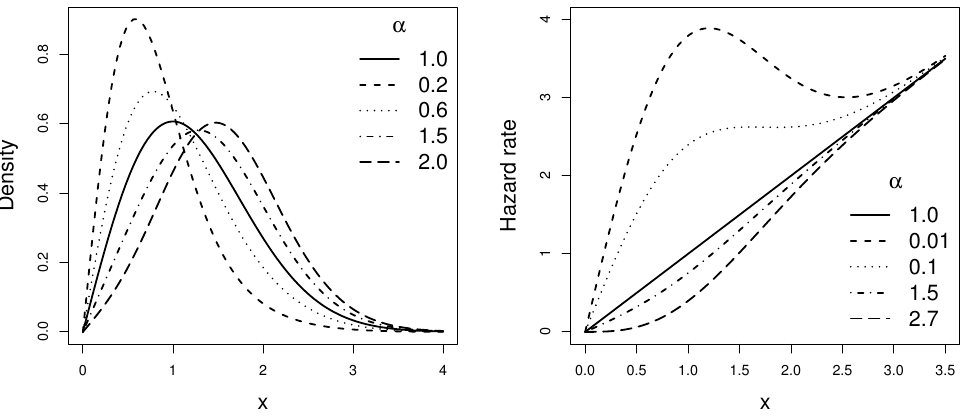
Figure 2. Plots of the density and hazard rate functions of the LR distribution for σ = 1 and different values of α